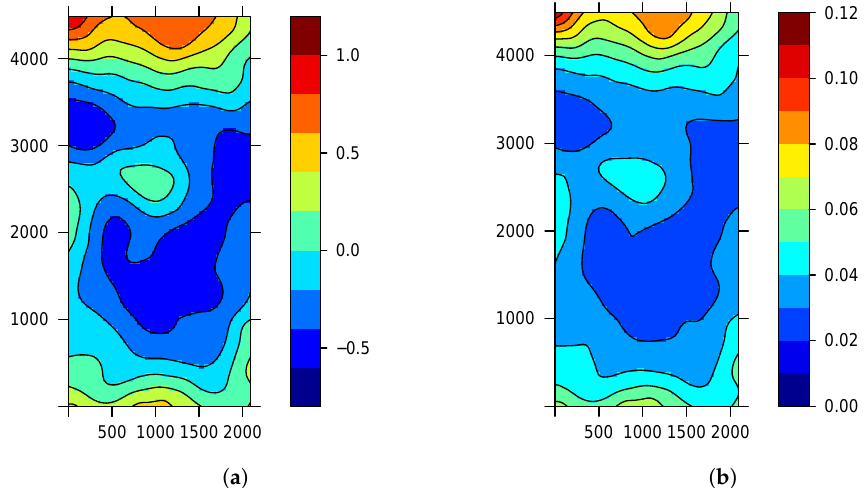
Figure 2. Posterior mean of the spatial effect ( a ) and of π i | Y ( b ) using the complete